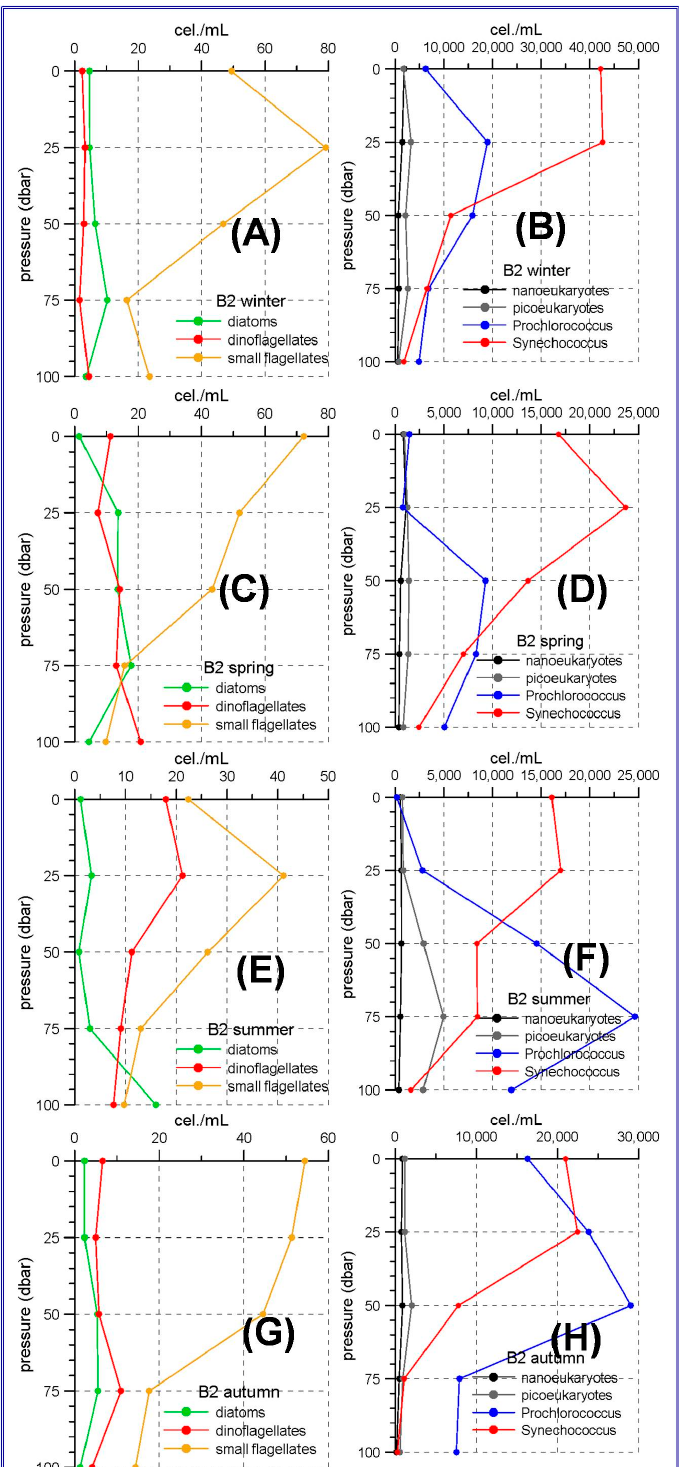
Figure 4. ( A ) shows the winter average vertical distribution of diatom abundances (green line), small flagellates (yellow line) and dinoflagellates (red line) at station B2. ( B ) shows the winter average vertical distribution for nanoeukaryotes (black line), picoeukaryotes (grey line), Prochlorococcus (blue line) and Synechococcus (red line) at the station B2 (solid line). ( C , D )are the same for spring, ( E , F ) for summer and ( G , H )for autumn.